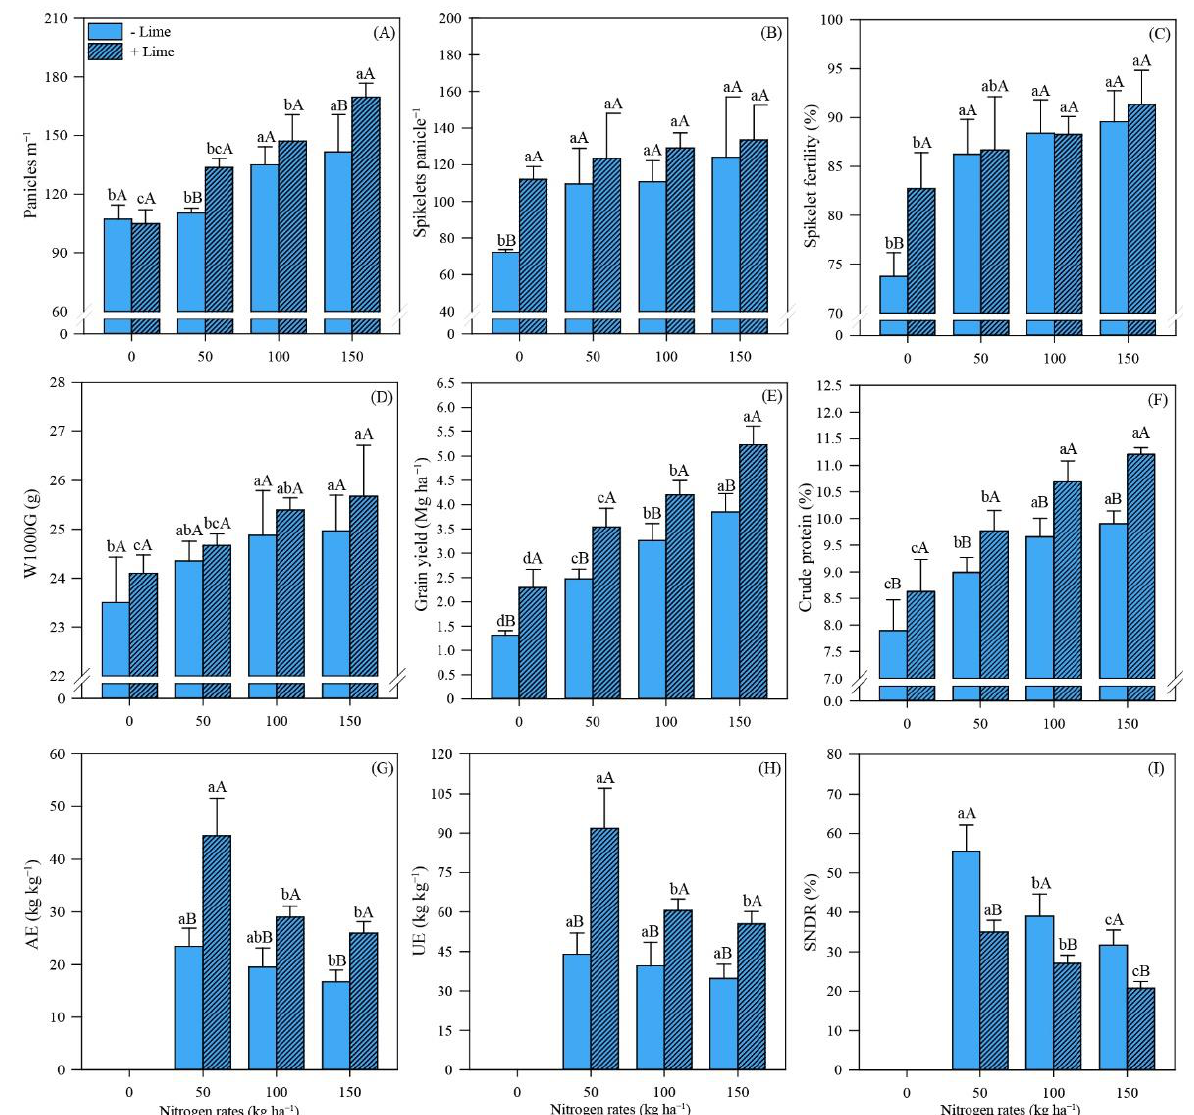
Figure 3. Number of panicles per m 2 ( A ), number of spikelets per panicle ( B ), spikelet fertility ( C ), 1000-grain weight ( D ), and grain yield ( E ) of upland rice, as well as crude protein ( F ), agronomic efficiency ( G ), utilization efficiency ( H ), and soil N-dependent rate ( I ) under different treatments (0 (no N applied), 50, 100, and 150 kg N · ha − 1 × absence ( − Lime) and presence (+Lime) of lime application). Different lowercase and uppercase letters indicate significant differences between N rates and lime applications, respectively, by Student’s t -test at p ≤ 0.05. The error bars express the standard error of the mean ( n =